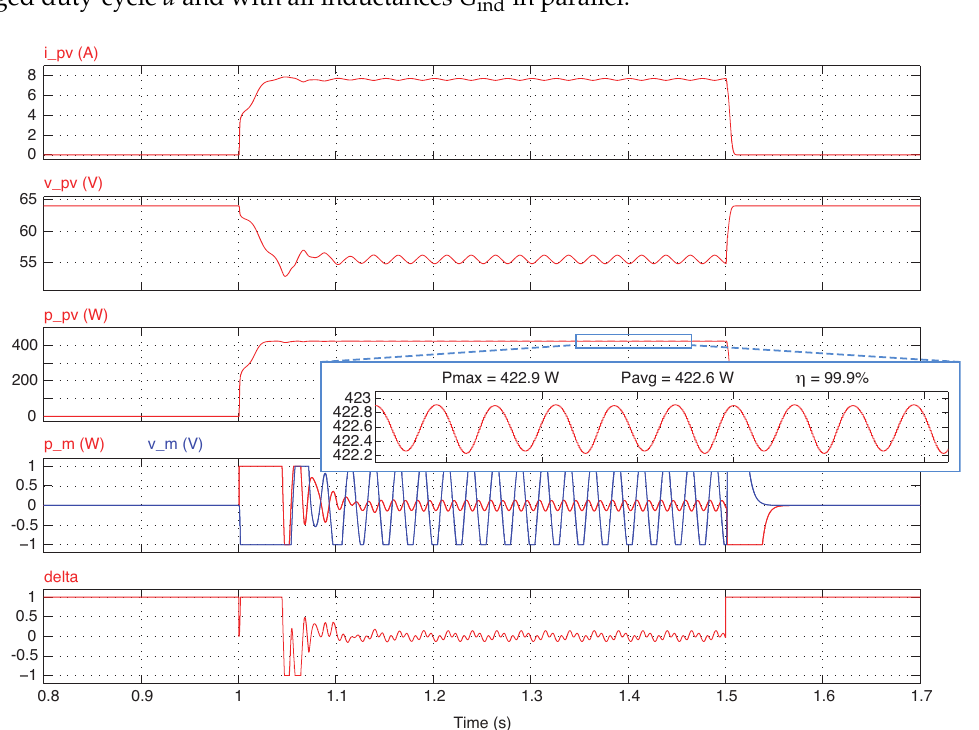
= ( d − V ) / r o j v pv j , and therefore a variation in j